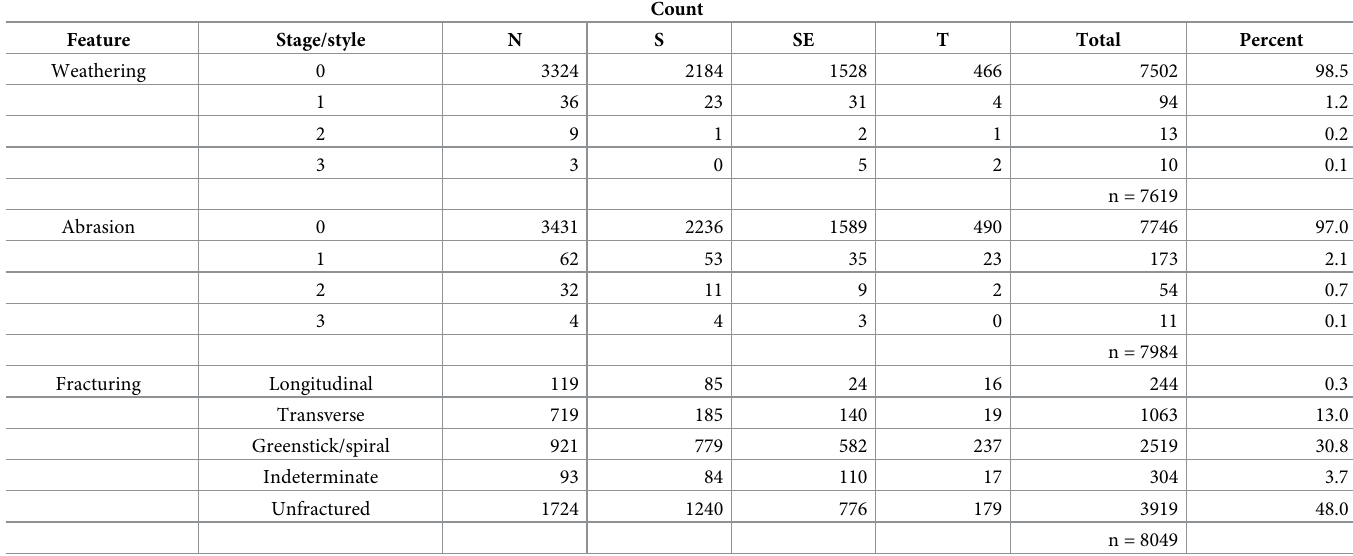
Table 4. Bone surface modifications and fracturing at the four largest HR quarries. Weathering, abrasion, and fracturing categories are adapted from Ryan et al. [25]. Fracturing data totals less than 100% due to a few bones fitting into unlisted